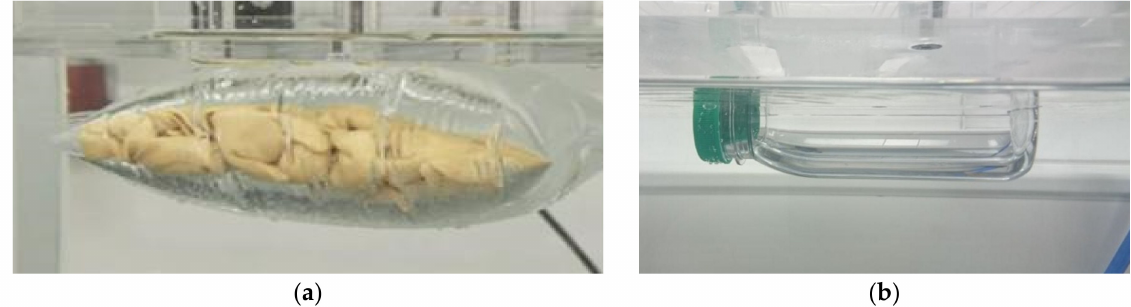
Figure 11. Leak detection in a bag/pouch ( a ) and bottle ( b ), reprinted with permission from WITT Polska.